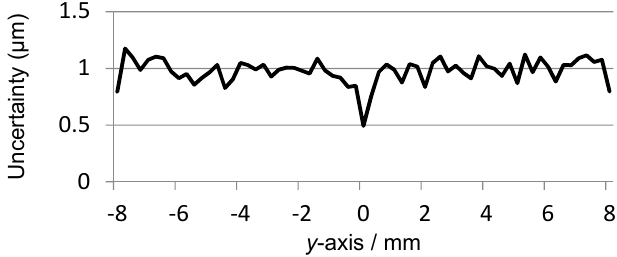
Figure 11. Uncertainty of the y -coordinate readings.